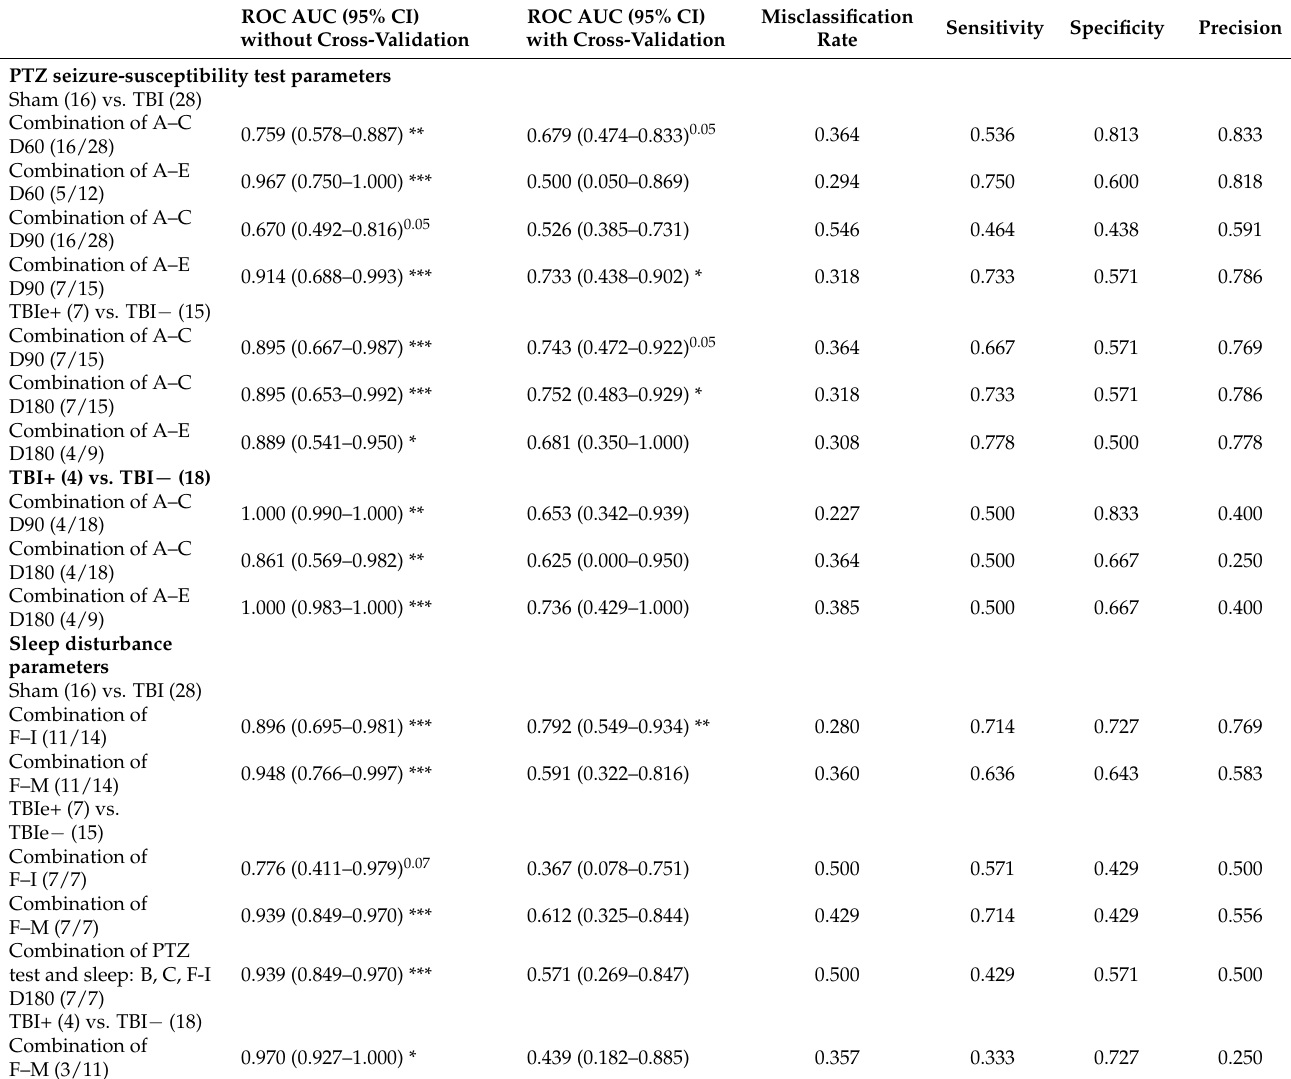
Table 5. Pentylenetetrazol (PTZ) seizure susceptibility test and sleep parameters as combinatory biomarkers of prior traumatic brain injury (TBI) and post-traumatic epileptogenesis. Combination of PTZ test parameters performed moderately well in differentiating sham vs. TBI and TBIe+ vs. TBIe − animals, and survived the leave-one-out cross-validation. Parameters included in the combination biomarkers are specified in the footnote. Note that none of the individual PTZ test parameters differentiated the sham vs. TBI animals, but some of them showed sensitivity and specificity as biomarkers of epileptogenesis (Supplementary Table S7). Several individual sleep parameters showed sensitivity and specificity as biomarkers of prior TBI and epileptogenesis (Supplementary Table